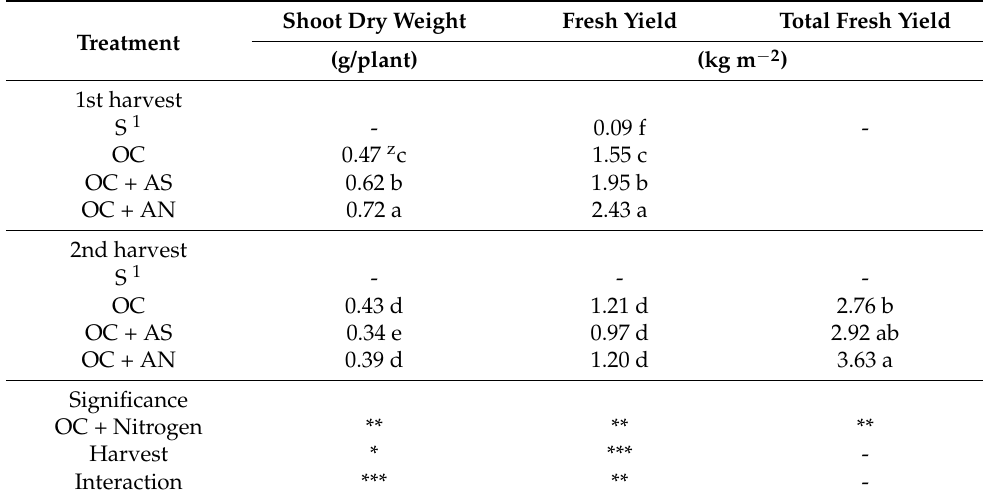
Table 1. Effects of the addition of organic compost and inorganic nitrogen fertigation on shoot dry weight and fresh yield of coriander on two successive harvests.